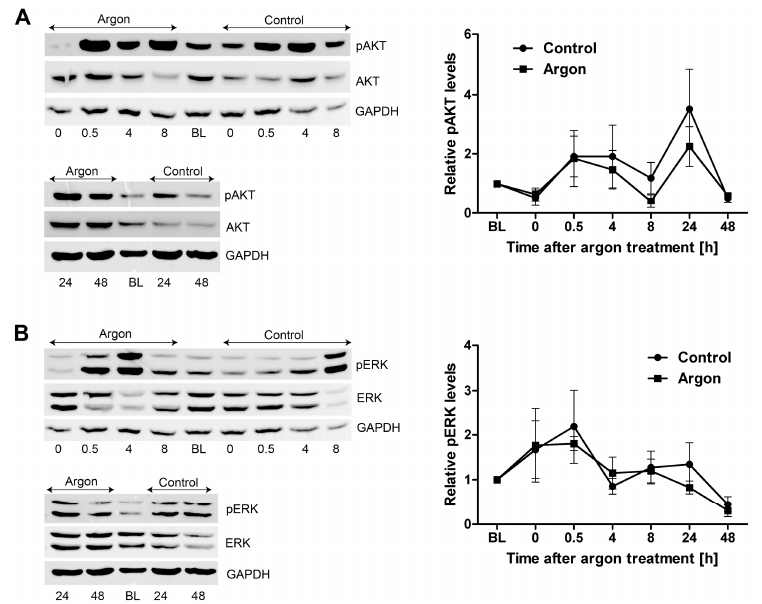
Figure 4. Argon preconditioning does not activate AKT and ERK. Cardiac cells (200,000 cells/cm²) were subjected either to room air (control) or a mixture of argon (argon) for 1 h. Phosphorylation of the protein kinases was assessed at distinct time points (0 h, 0.5 h, 4 h, 8 h, 24 h, and 48 h after preconditioning) by Western blotting and normalized to the unphosphorylated form of the protein. ( A ) Representative immunostaining results as well as the densitometric analysis of AKT; ( B ) Western blot analysis of ERK. Data represented means ± SEM of at least four independent experiments.